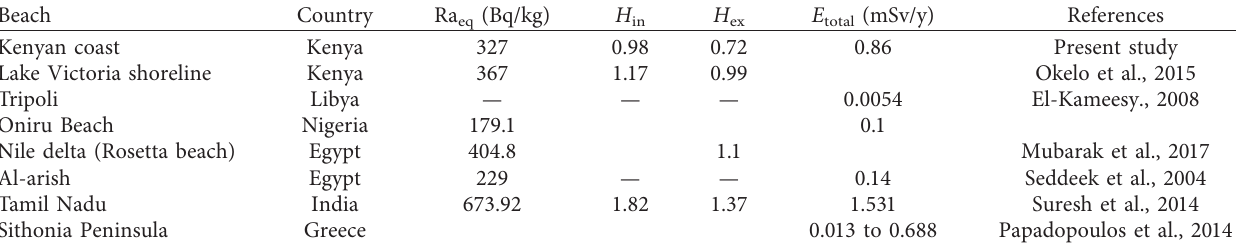
Table 5: Comparison of the average activity concentrations of 232 Th, 238 U, and 40 K in sands on selected Kenyan coastline beaches and other regions around the